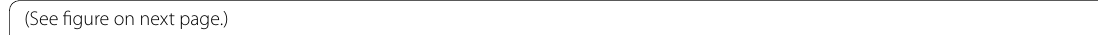
(See figure on next page.) Fig. 7 A Oblique sagittal PD- weighted MR image shows complete obliteration of the rotator interval with no observed fat planes or coracohumeral ligament (encircled area). B Oblique axial fat-suppressed PD-weighted MR image shows anterior and posterior extracapsular edema (encircled area). C Oblique coronal fat-suppressed PD-weighted MR image shows edema at humeral portion of axillary recess (arrow). D Oblique axial fat-suppressed PD weighted MR image shows effusion in long head biceps tendon sheath (arrow). E Oblique coronal T2-weighted MR image shows thickened joint capsule and measurement of maximum capsular thickness of glenoid and humeral portions of axillary recess with effusion at axillary recess. F Oblique coronal fat-suppressed PD-weighted MR image shows measurement of maximum height and width of axillary recess at the same